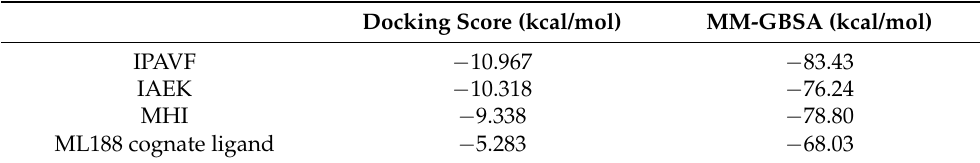
Table 1. Values of the docking score and of MM-GBSA free energy of the best poses obtained through induced-fit